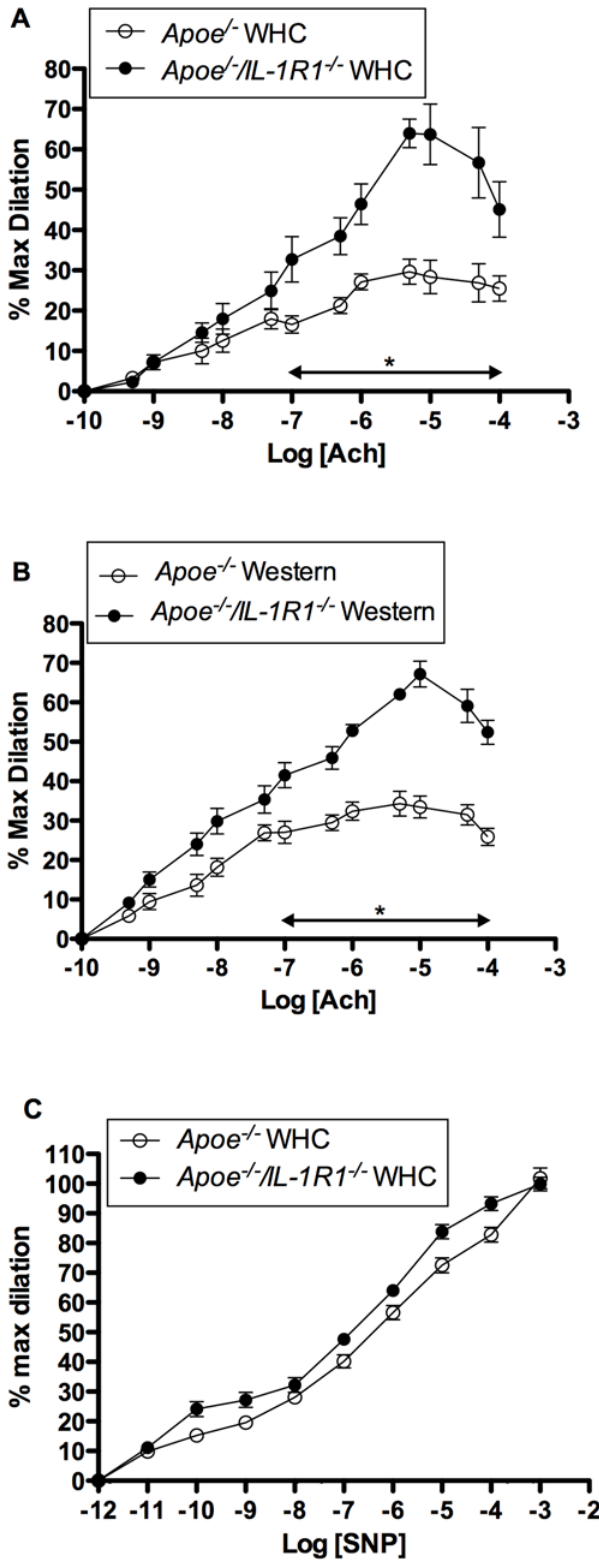
Figure 3. Vascular reactivity of arterioles from Apoe 2 / 2 and Apoe 2 / 2 /IL-R1 2 / 2 mice. (a–b) % maximum dilation of pre-constricted mesenteric arterioles (EC 80 PE) to acetylcholine. (c) Endothelium- independent relaxation responses assessed by superfusion of sodium